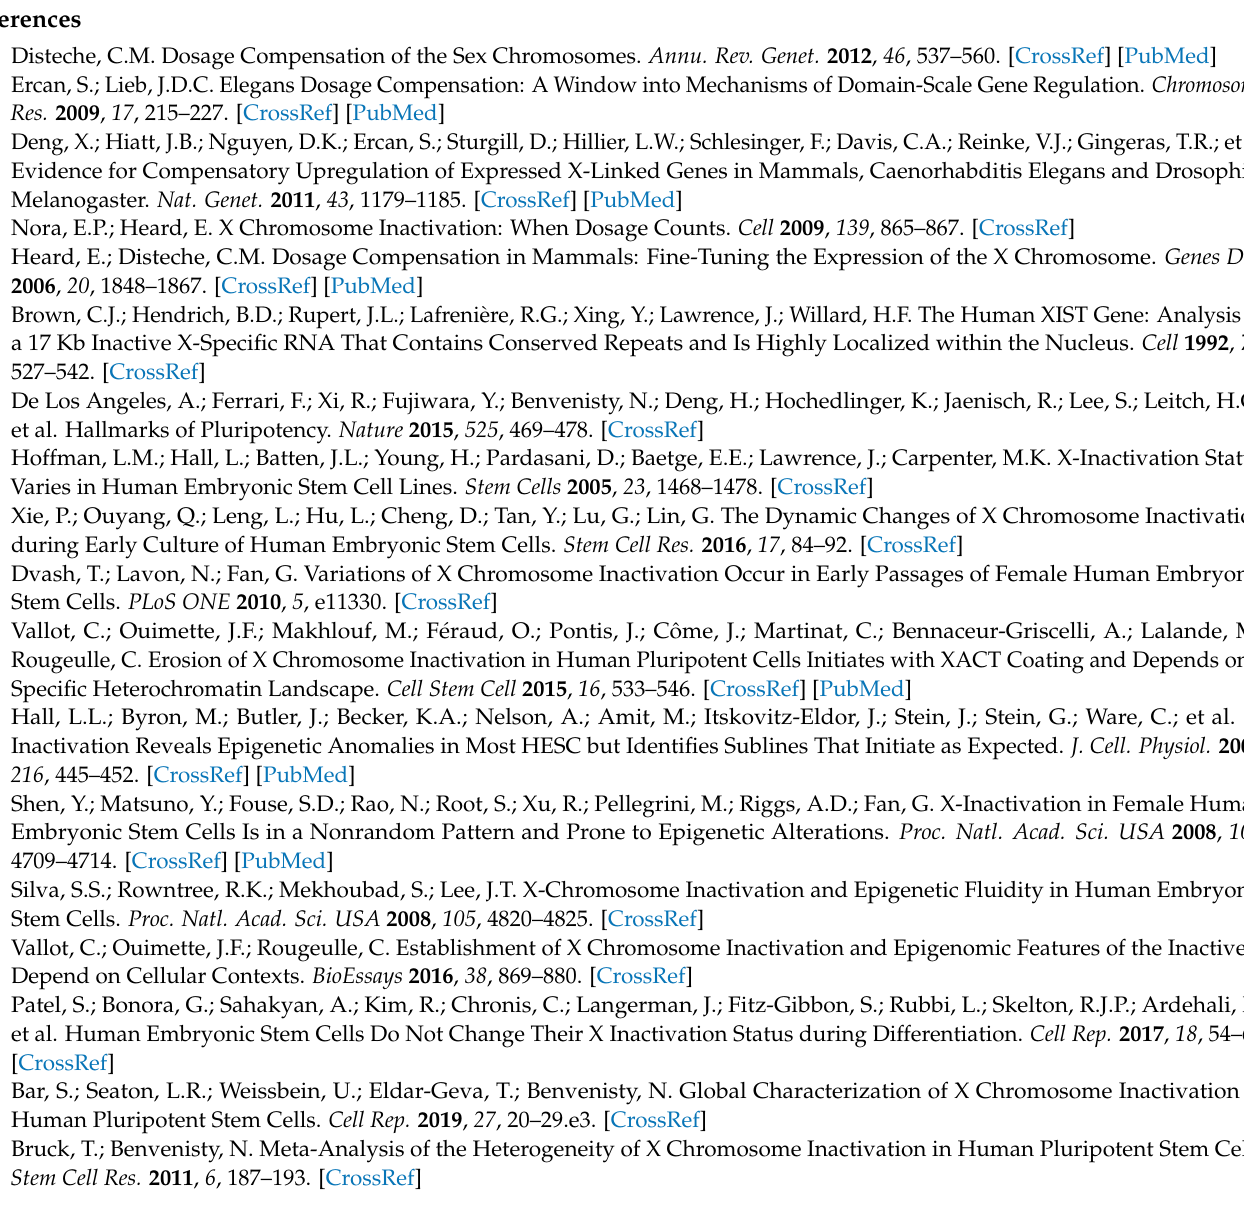
Figure S2: Allelic ratio of primed and naïve samples and primed geographical chromosome X expression; Figure S3: Geographical chromosome X expression, epiblast correlation, XIST expression and FGF ratios; Table S1: Sample